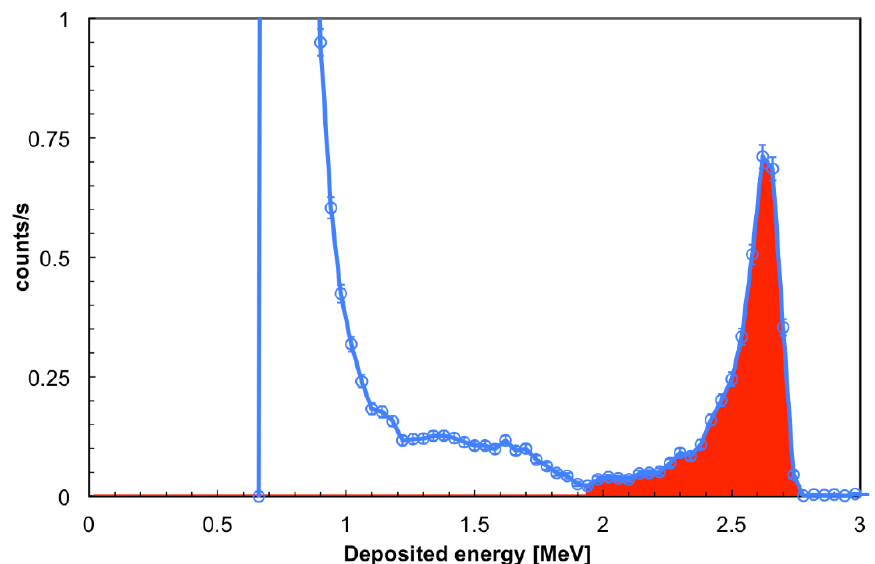
Figure 15. The deposited energy spectrum collected in the inside position with the reference detector. The colored area starts from the alpha endpoint, and contains 97% of the detected tritons (see text). The typical spectrum measured with the SiLiF detectors under test at the inside position is shown in Figure 16. The colored area was normalized to the impinging flux and provides the detection efficiency for the 1.5 MeV energy threshold. The detection efficiency was evaluated for all the 32 detectors, with two nominal energy thresholds at 1 and 1.5 MeV, and the results are summarized in Figure 17.